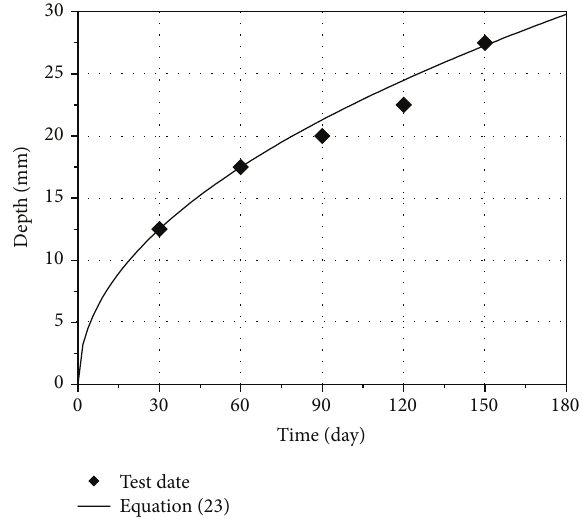
Figure 6: Accuracy comparison of Models (23) and (26) using experimental values reported in reference